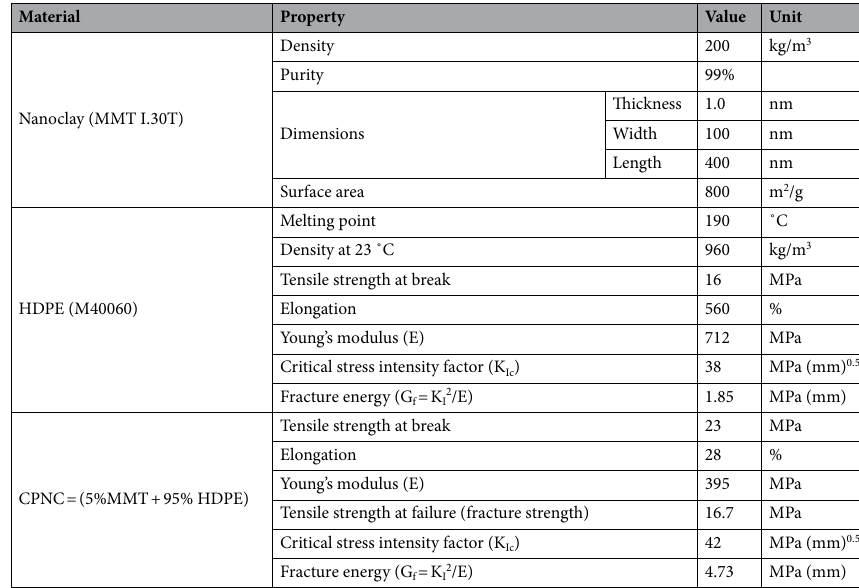
Table 1. Properties of MMT (I.30T) nanoclay, HDPE (M40060), and CPNC made of